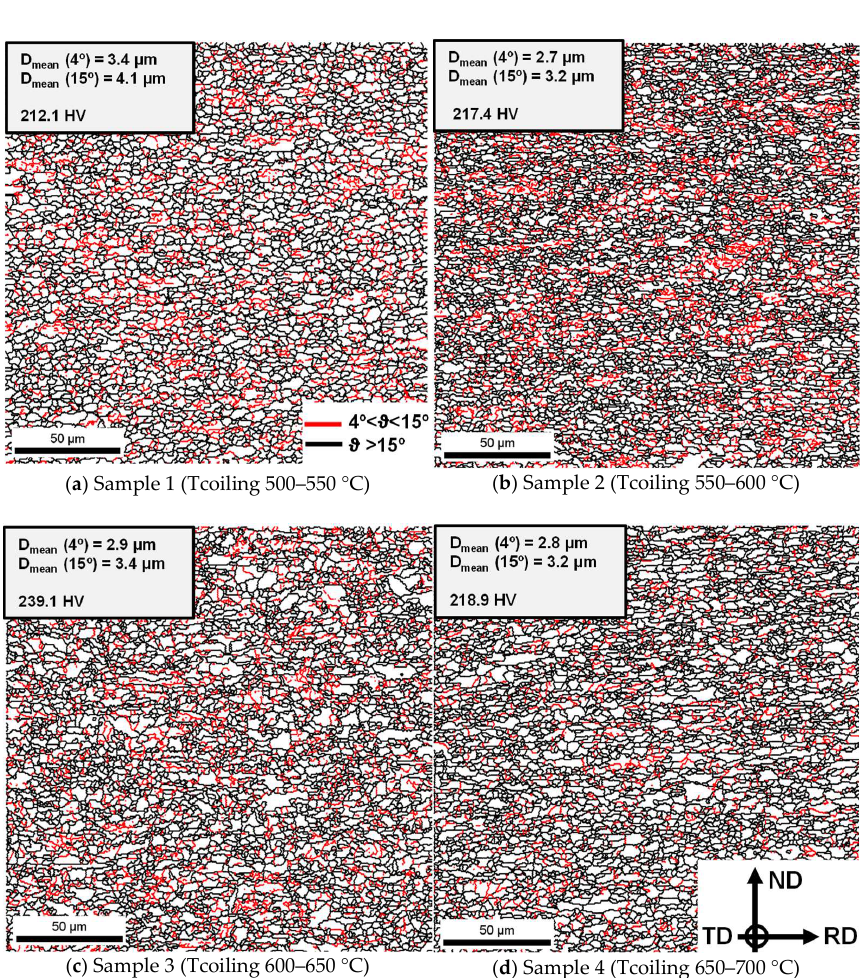
Figure 6. Image of the microstructure obtained via SEM-EBSD (grain boundary maps). Different coiling temperatures: ( a ) 525–550 ◦ C; ( b ) 550–600 ◦ C; ( c ) 600–650 ◦ C; ( d ) 650–700 ◦ C. Figure 7a,b show the grain size distribution corresponding to Sample 2 (coiling tem- perature of 550–600 °C), taking low-angle-misorientation criteria and both center and quarter positions through thickness into consideration. A similar unit size distribution was quantified for both locations, reflecting the formation of a homogeneous microstruc- ture through thickness. The same analysis could be extended to the other specimens by also comparing samples taken from the central region and closer to the sample surfaces. Figure 8a,b show the grain size distribution corresponding to the center and quarter, both